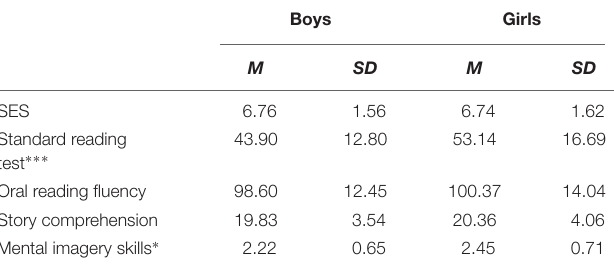
TABLE 2 | Sex differences on SES and reading